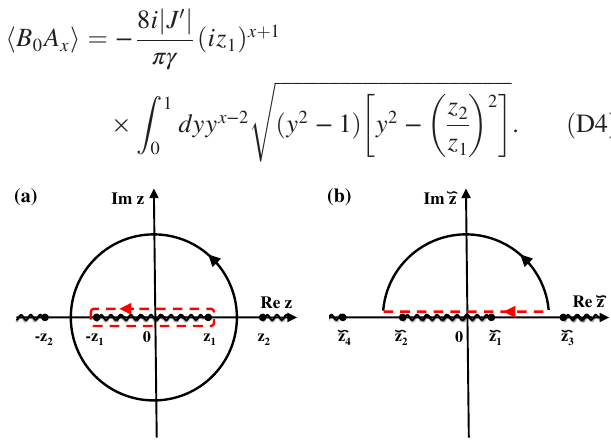
FIG. 10. Contours for the evaluation of pair contraction functions for (a) J ¼ 0 and (b) an example of J ≠ 0 . Solid lines are the original contours. Dashed lines are the deformed contours. Jagged lines are the branch